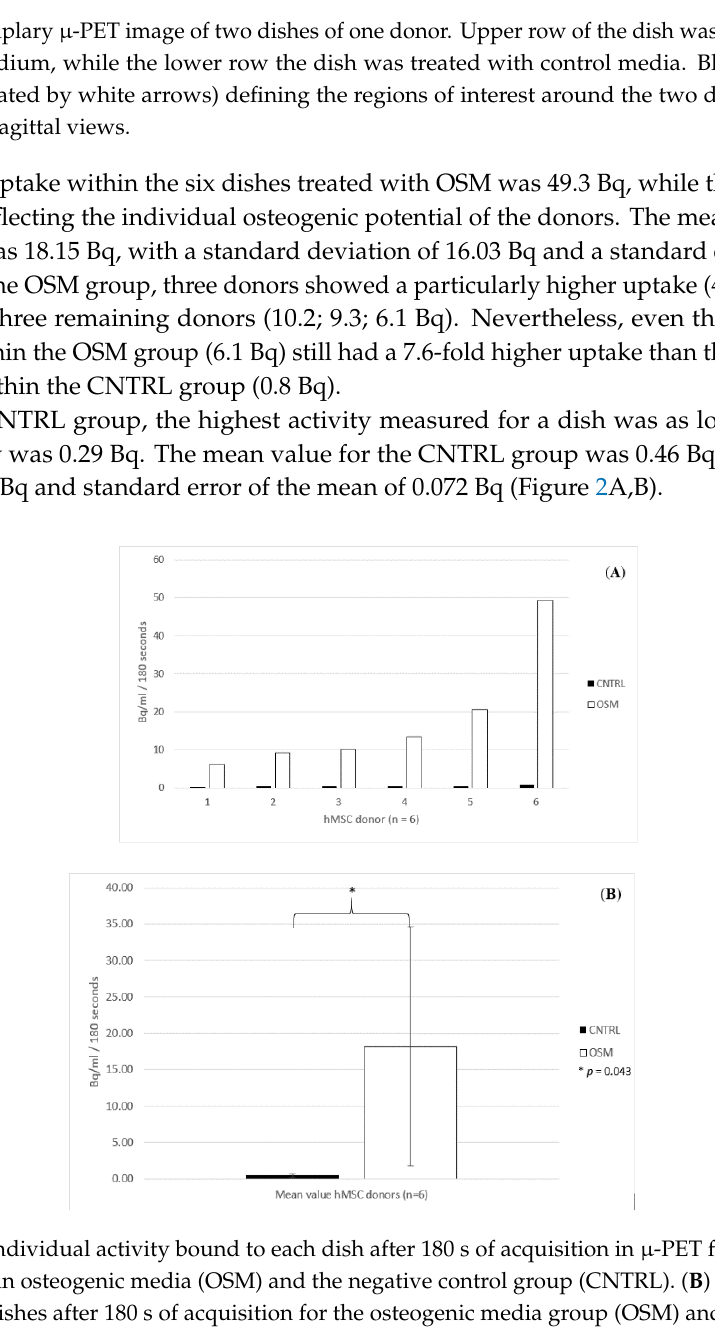
Figure 2. ( A ) Individual activity bound to each dish after 180 s of acquisition in µ-PET for donors 1–6 ( n = 6) treated in osteogenic media (OSM) and the negative control group (CNTRL). ( B ) Mean activity bound to the dishes after 180 s of acquisition for the osteogenic media group (OSM) and the negative control group, +/ − standard deviation, p = 0.043 ; * = significant difference between the two groups, p ≤ 0.05.